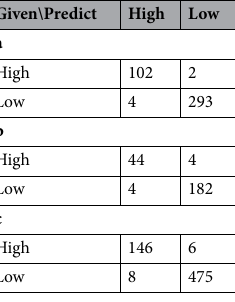
Table 1. The results of confusion matrices for DM prediction (threshold at 126 mg/dl); (a) Training, N = 401 (b) test dataset, N = 234 (c) overall data; N = 635.